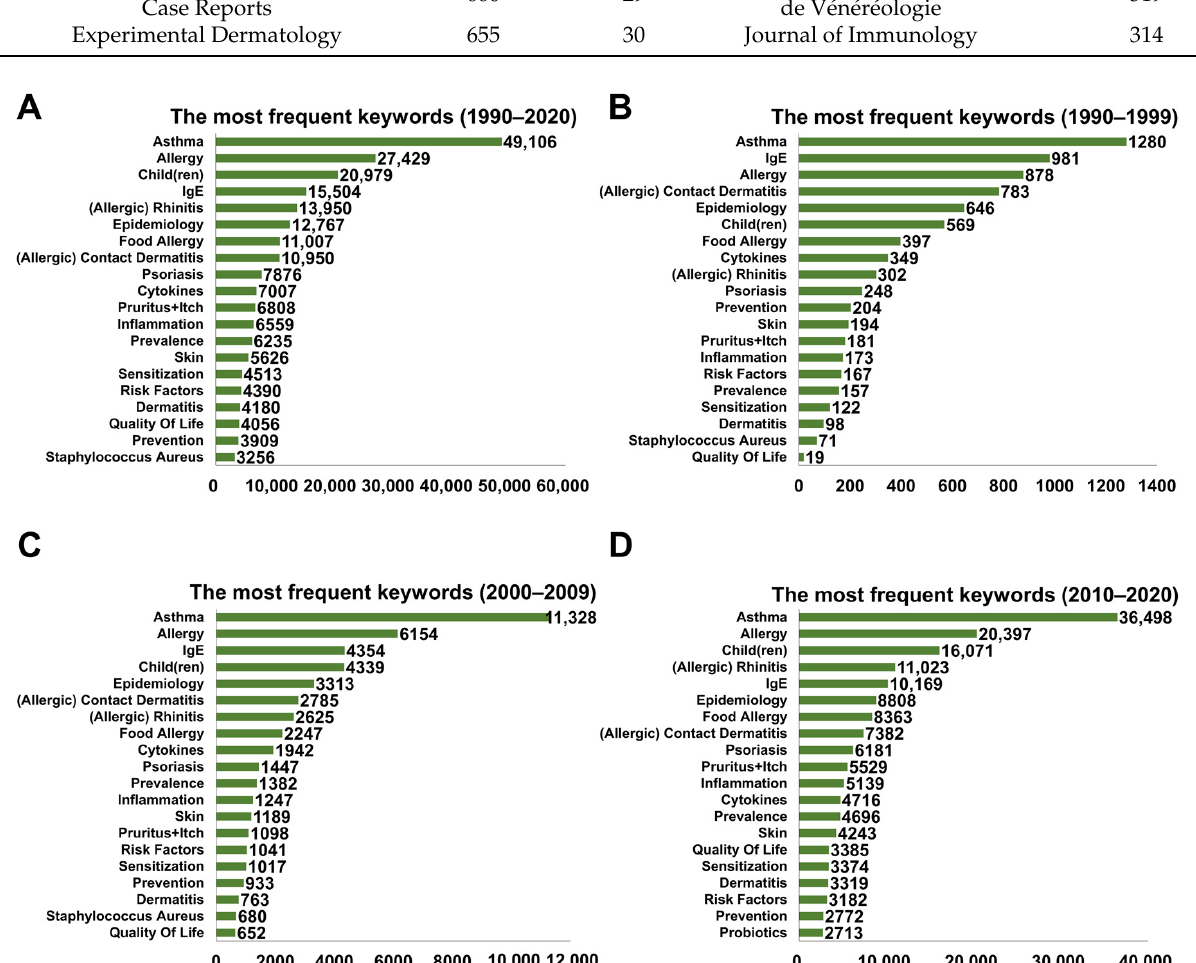
Figure 2. The most frequently used keywords ordered by occurrence in the period 1990–2020. ( A ) Number of the most frequently used keywords from 1990 to 2020 from publications in AD research. During the past three decades, ‘Asthma’, ‘Allergy’, ‘Child(ren)’, ‘IgE’, and ‘(Allergic) Rhinitis’ have been the most commonly used keywords; ( B ) Number of the